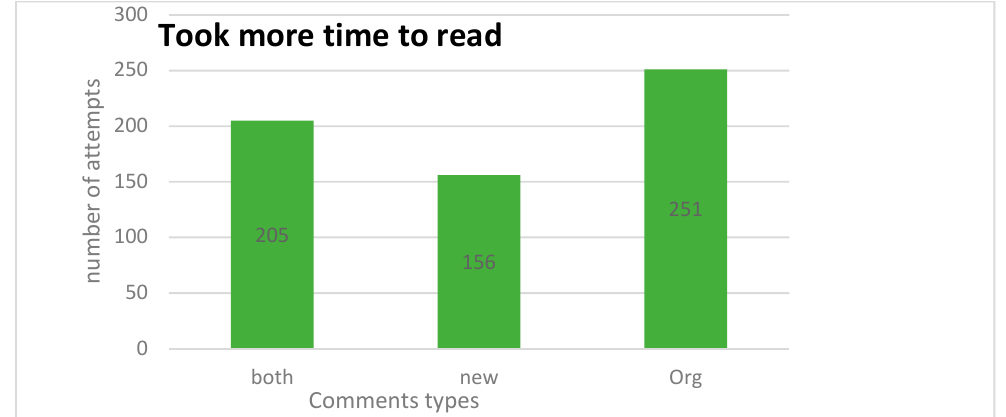
Figure 17. Result of question: which took more time to read ? Where “org” is an original comment from the sample.